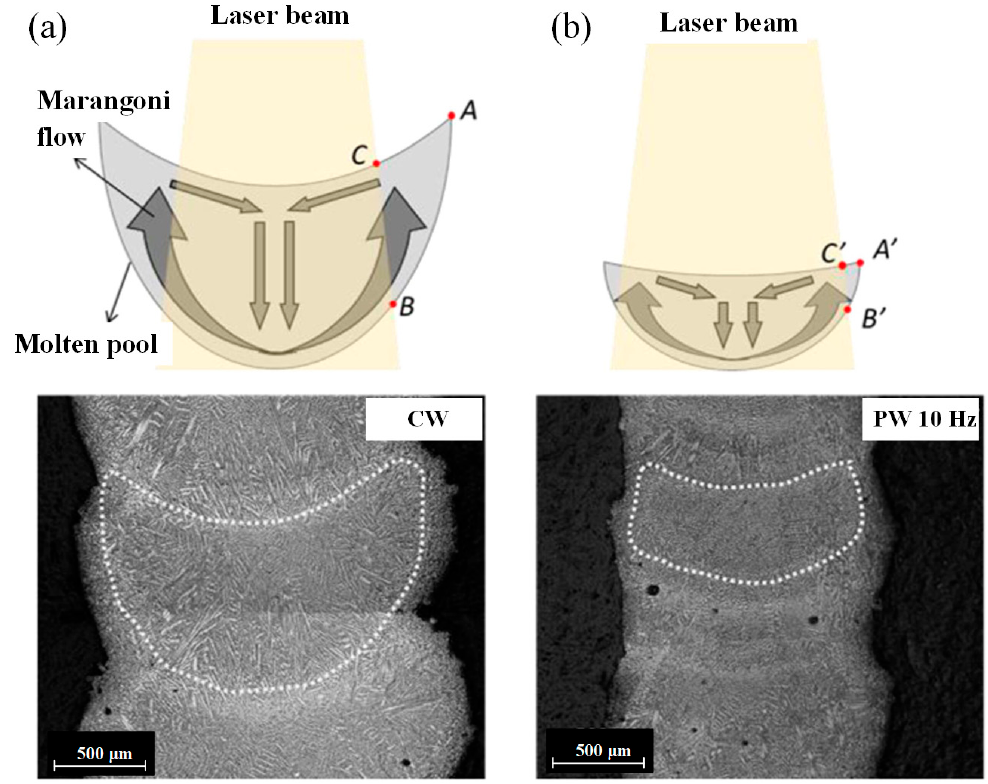
Figure 4. Marangoni flow within the cross-section of the IN718 thin walls when ( a ) CW and ( b ) 10 Hz PW laser are used. (Reprinted from ref. [32], copyright (2020), with permission from Elsevier).